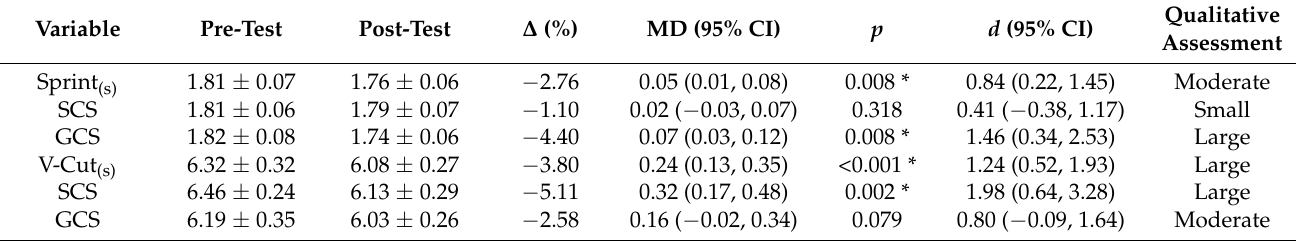
Data are presented in mean ± SDs. Sprint: linear sprint test of X m; V-Cut: change-of-direction maneuverability test; MD: Table 14. Adjusted means and effect sizes for performance test scores between the groups. mean difference; CI: confidence intervals; d : Cohen’s d effect size. * p < 0.05 pre- and post-training effect.